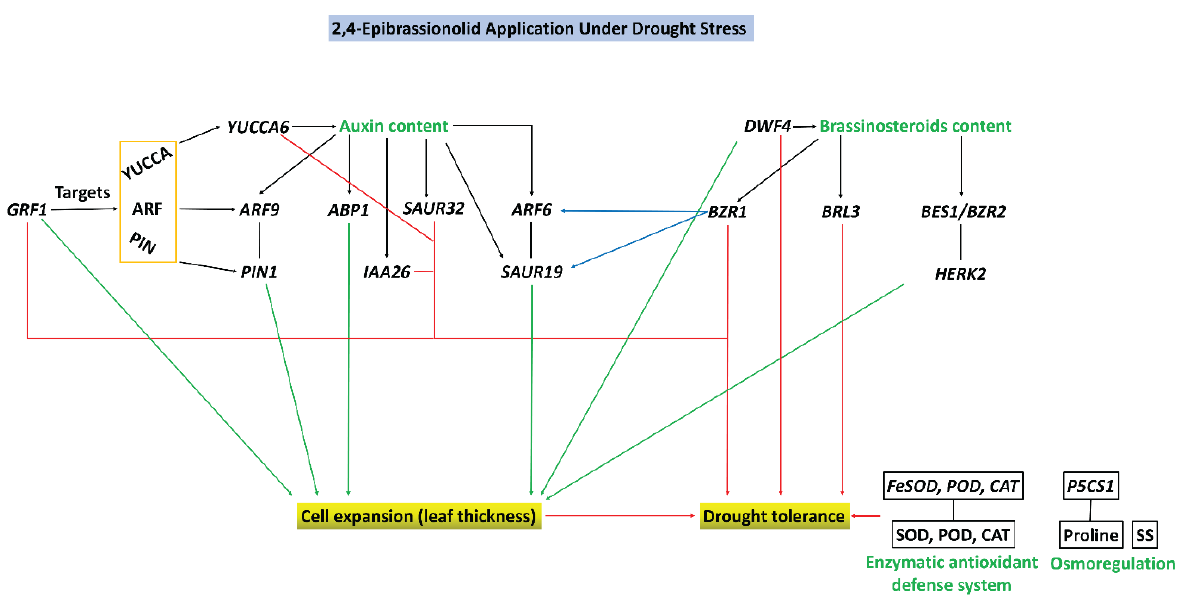
Figure 9. This schematic model shows the proposed mechanisms involved in drought tolerance regulation by 2,4-epibrassinolide (EBR) application. Integrative analyses found that EBR application regulated tolerance at anatomical, biochemical, and molecular levels under drought stress. Leaf thickness is increased by EBR under DS and improved drought tolerance and adaptation in tobacco plants. EBR application also conferred drought tolerance by improving the enzymatic antioxidant defense system and osmoregulation. BR and IAA crosstalk play crucial roles in drought tolerance. Black solid arrows show regulation. Green solid arrows indicate the regulation of cell expansion and, eventually, leaf thickness by the IAA and BR signaling pathways. Red solid arrows show the regulation of drought tolerance via the IAA and BR signaling pathways. Blue solid arrows show crosstalk between the IAA and BR signaling pathways.